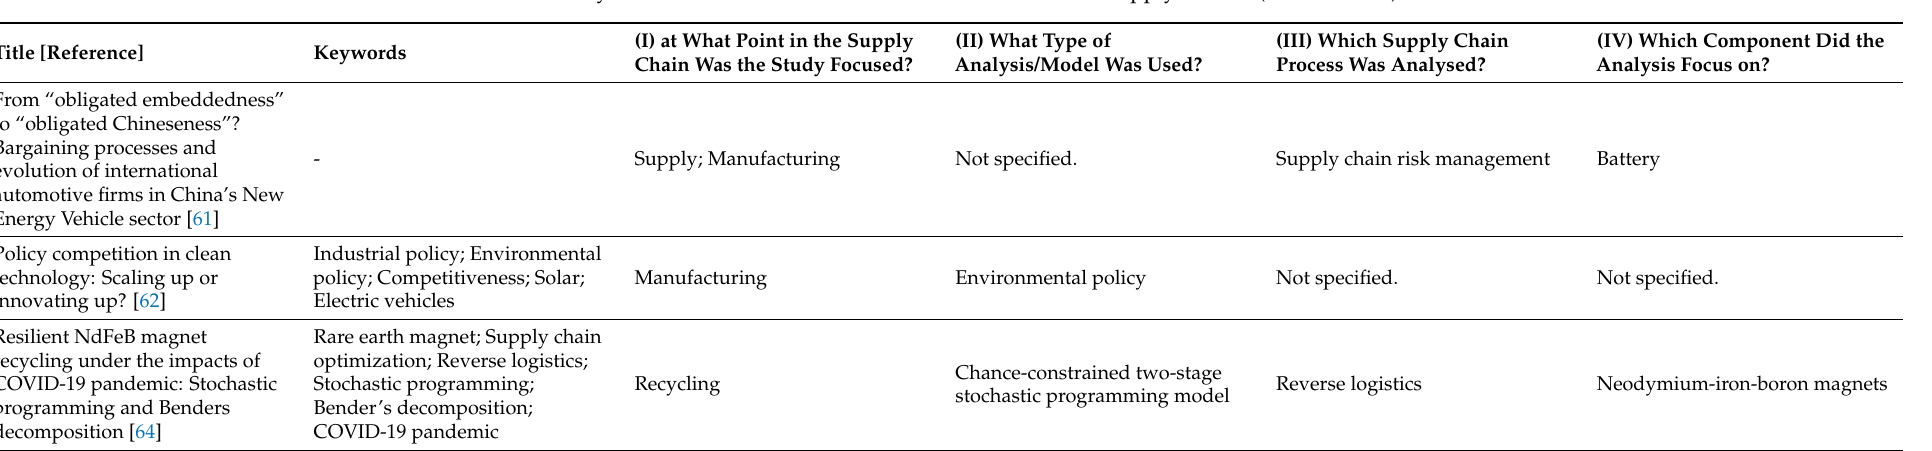
Table A7. PRISMA meta-analysis of documents found related to electric vehicles supply chains.